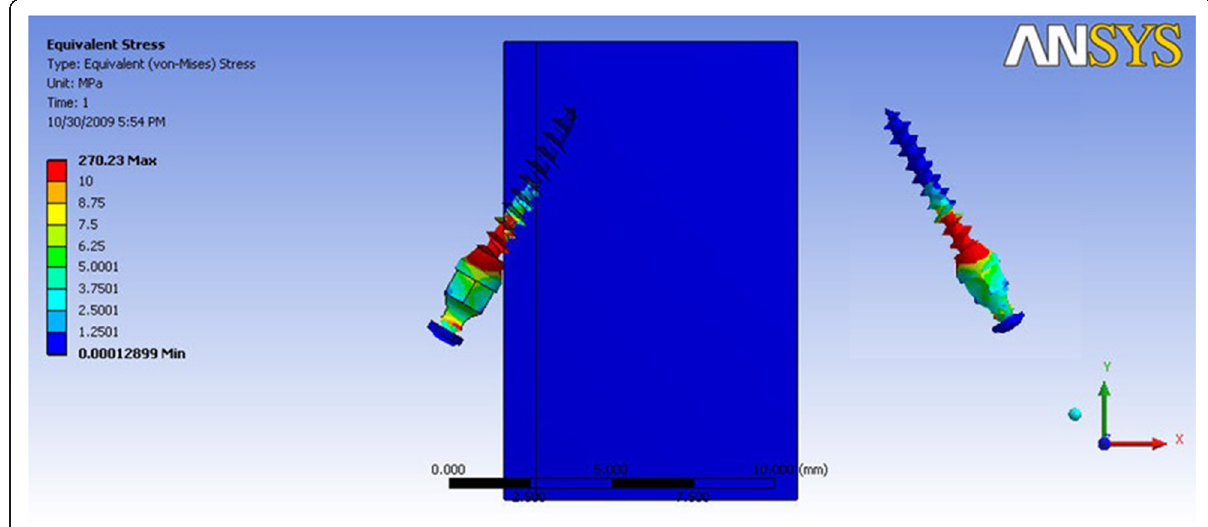
Fig. 4 von Mises stress distribution for mini-implant group 3a — anterior retraction: von Mises stress distribution seen at the bone-implant interface and in the mini-implant alone. Maximum stress seen in the mini-implant was at 270.12